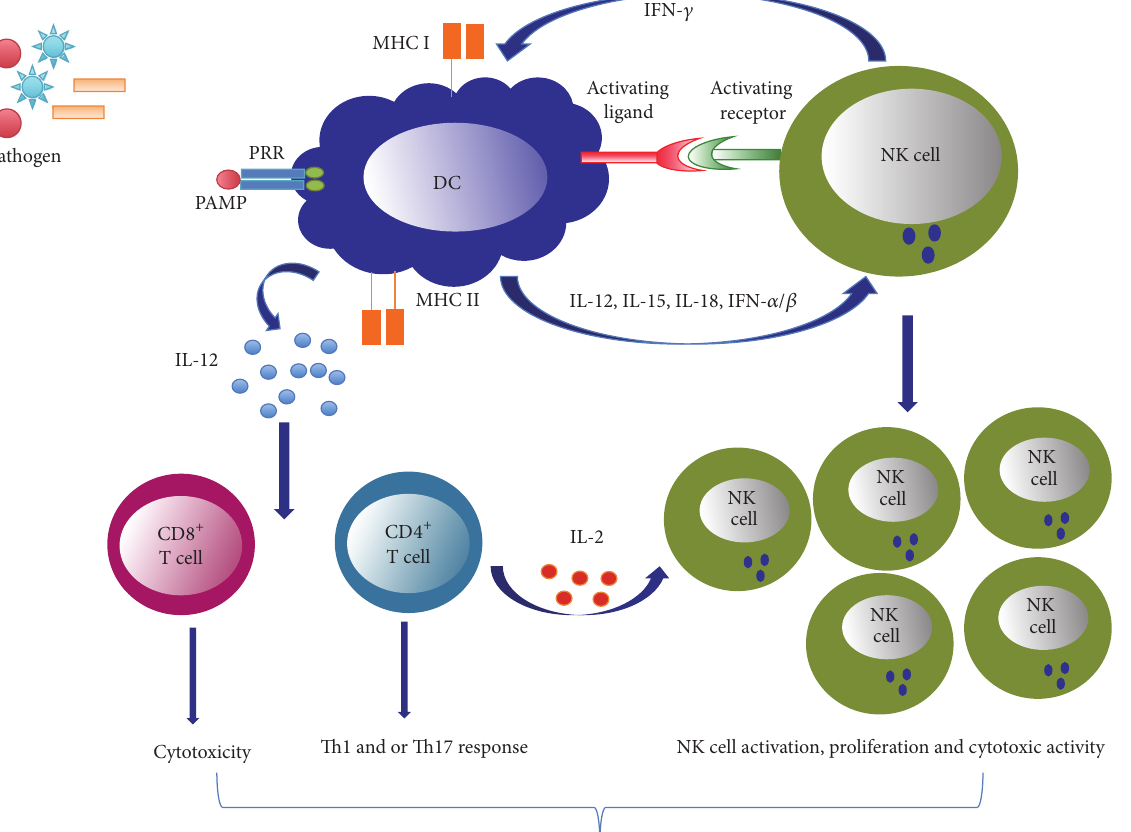
Figure 1: Bidirectional activation of NK cells and DCs for optimal immune response to microbial infection. DCs recognize pathogen- associated molecular patterns (PAMPs) found on the surface of pathogen through the expression of pattern recognition receptor (PRR). Following recognition of pathogen, DCs release cytokines such as IL-12, IL-15, IL-18, and IFN- 𝛼 / 𝛽 . These cytokines produced by DCs as well as the interactions of DC with NK cell activation receptors promote NK cell activation, proliferation, and cytotoxicity. Reciprocally, NK cells release IFN- 𝛾 to promote DC maturation and release of IL-12. IL-12 produced by DC further promotes CD8 + T cell and/or CD4 + T cell activation depending upon the nature of pathogen. IL-2 produced by CD4 + T cell can also stimulate NK cell activation for optimal immune